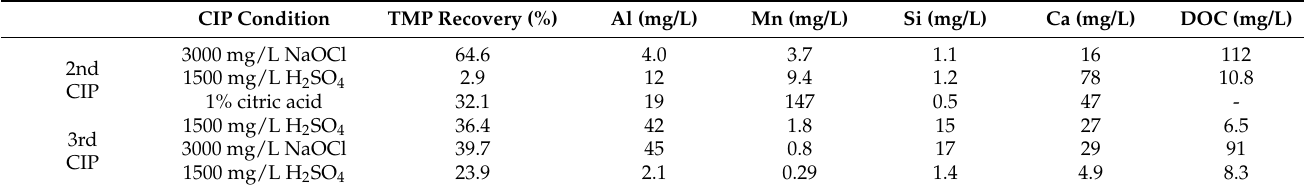
Table 4. Analysis of substances eluted during CIP and TMP recovery with each chemical cleaning. CIP